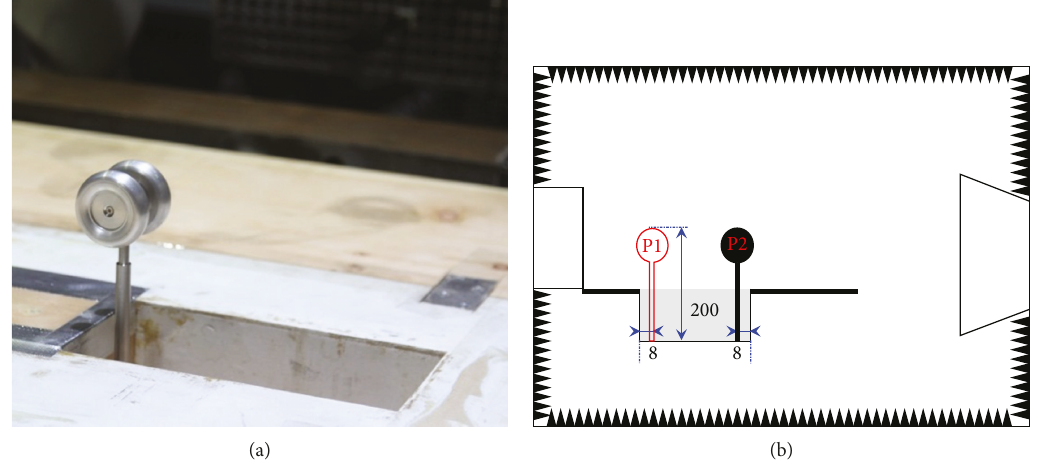
Figure 6: Test setup of the cavity noise characterization with a landing gear model: (a) landing gear model; (b) schematic for the con fi guration (in mm).